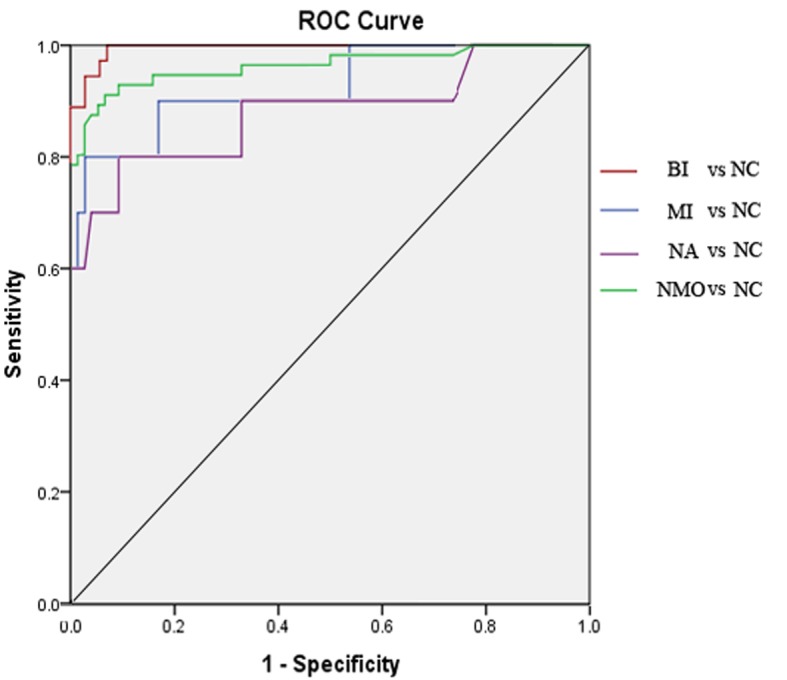
ROC curves of comparisons of FA values of the posterior intraorbital optic nerve among the NMO subgroups and normal controls.The AUC (0.99) and sensitivity (100%) in BI vs. NC were larger than those in the other subgroup comparisons. (BI, biocular impairment; MI, monocular impairment; NA, normal-appearing; NC, normal control; AUC, area under the curve).